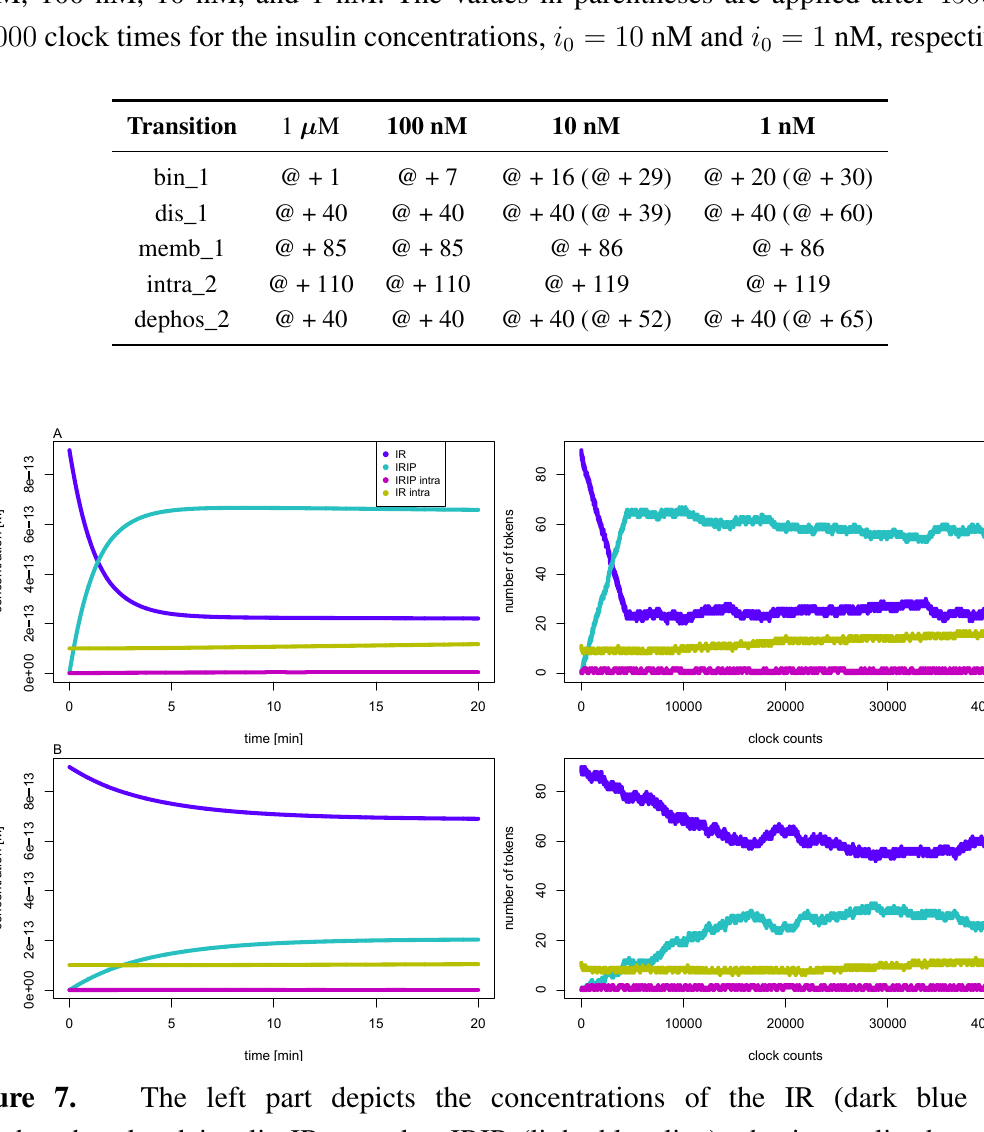
Adaption of time delays of timed transitions to initial concentrations of insulin,